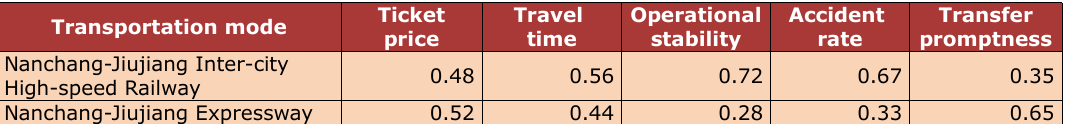
Table 2. Eigenvalues of the two kinds of transportation modes in Nanchang-Jiujiang transportation